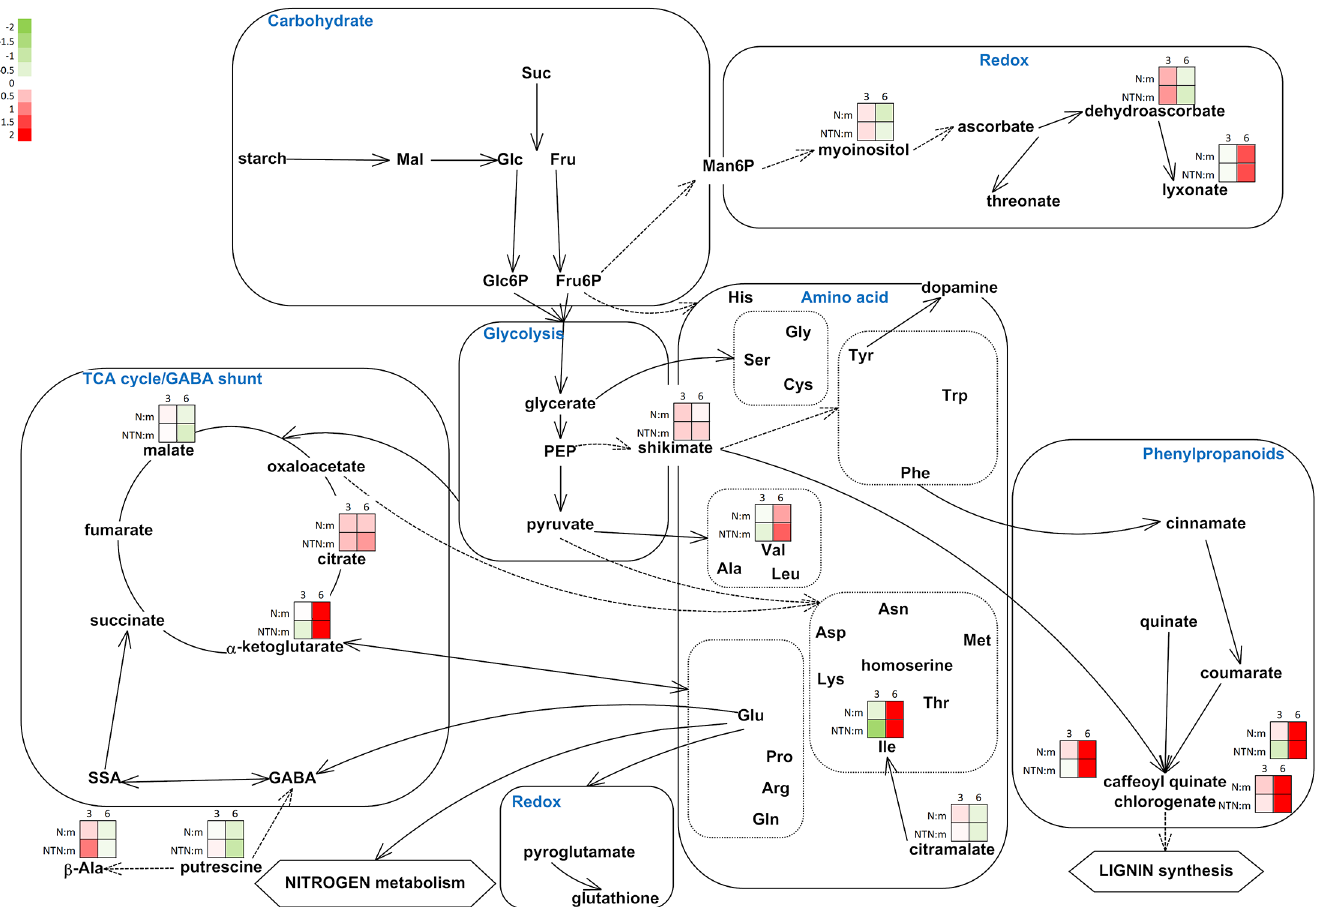
Fig 4. Integration of the changes in the metabolites associated with selected metabolic pathways in the upper non-inoculated leaves from the PVY N -inoculated and PVY NTN -inoculated plants, relative to the mock-inoculated plants. The metabolites identified from the primary and secondary metabolism and from redox reactions are shown. Each coloured square represents the log2 ratios of the concentration (red, high; green, low) at 3 and 6 dpi in the upper non-inoculated leaves of the PVY N -inoculated (N:m) and PVY NTM -inoculated (NTN:m) plants, relative to the mock-inoculated plants (as indicated). MapMan BINs linked to primary metabolism: 2.1.1 major CHO metabolism, sucrose synthesis; 2.2.1 major CHO metabolism, sucrose degradation; 2.2.2 major CHO metabolism, starch degradation. MapMan BINs linked to the GABA shunt: 13.1.1.1 amino-acid metabolism, GABA synthesis; 8.1. TCA; 22. polyamine metabolism; 12.2.1002 N-metabolism, ammonia. MapMan BINs linked to secondary metabolism: 16.2.1 secondary metabolism, phenylpropanoids biosynthesis; 13.1. amino-acid synthesis.